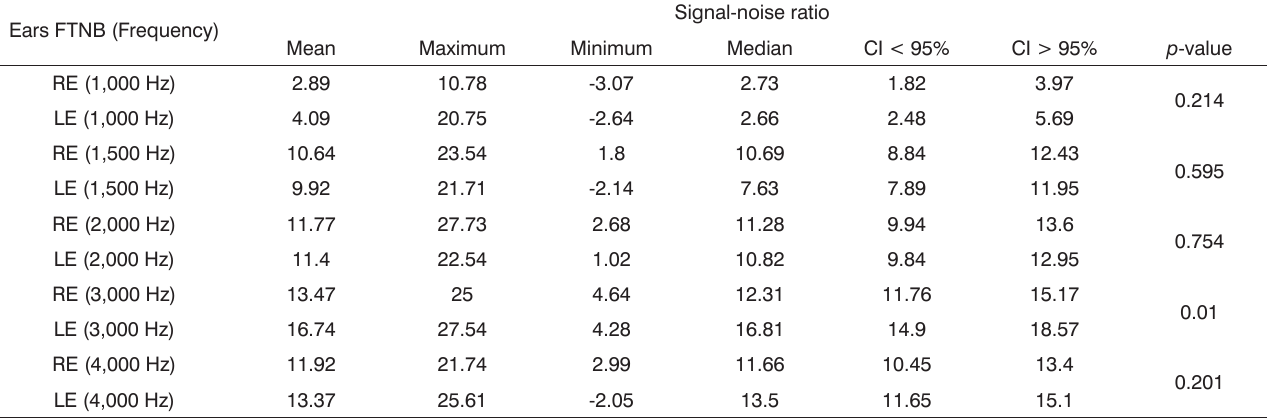
Table 1. Description of the signal-noise ratio variable of TEOAEs (in dB SPL), for each frequency band, in both ears tested of full term newborns.